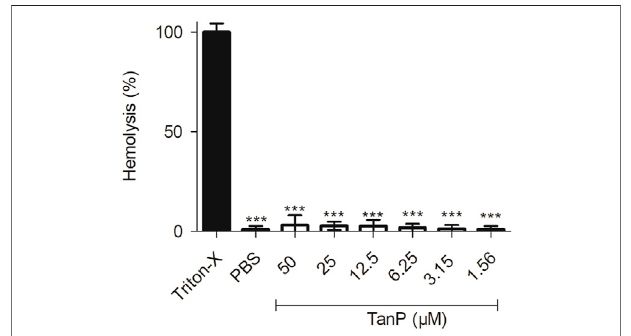
FIGURE 3 | Hemolytic activity of TanP in vitro . TanP was tested (1.56 – 50 μ M), the statistical signi fi cance was performed using ANOVA followed by Tukey ’ s test and expressed as mean ± SD (n (cid:2) 3). *** p < 0.001 compared with the positive control group